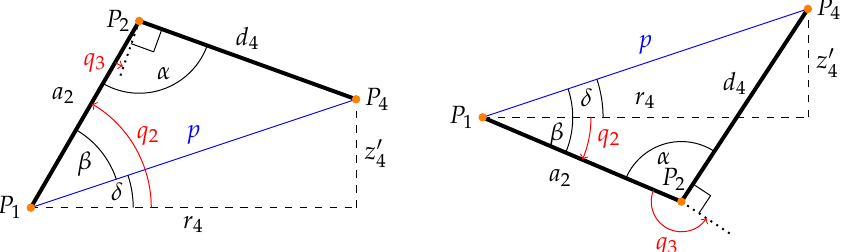
Figure 4. Inverse kinematics of the chosen robot structure—diagram for the calculation of q 2 and q 3 (two different